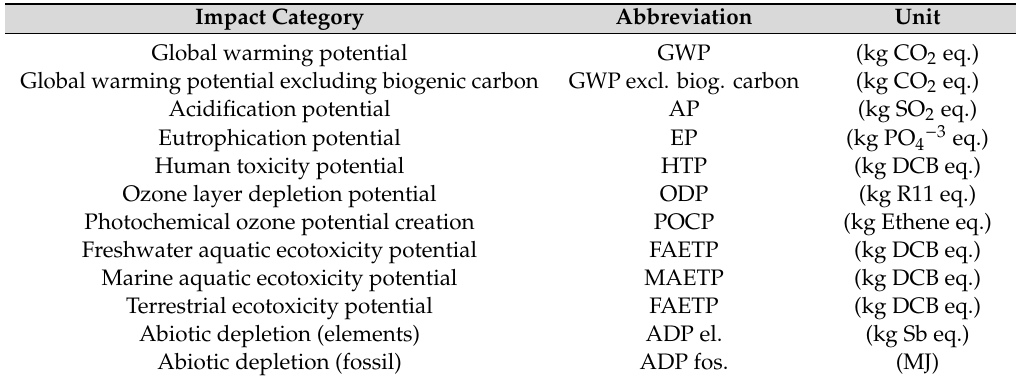
Table 1. CML 2001 midpoint impact